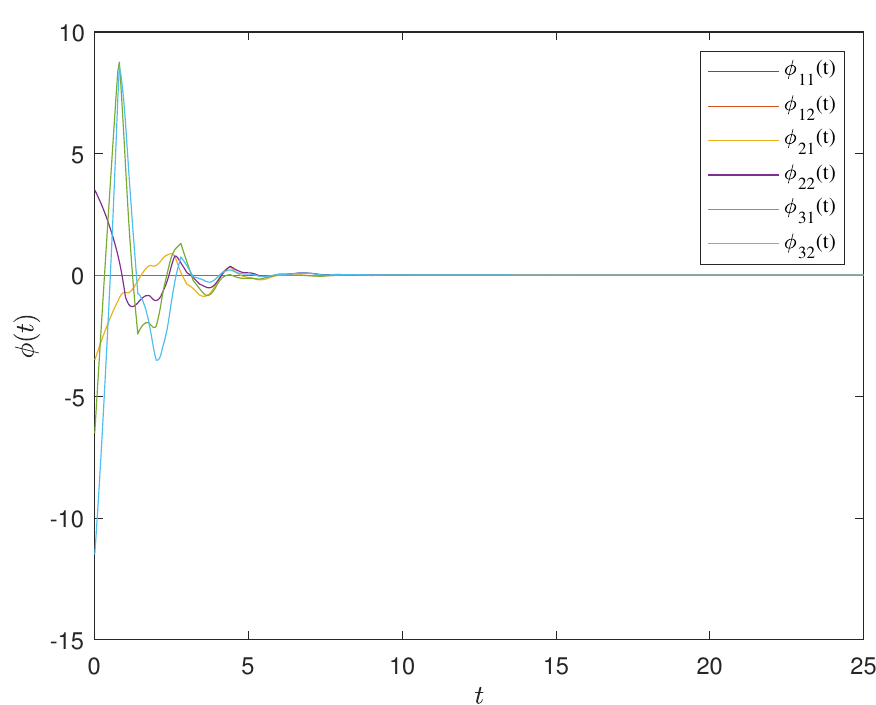
Figure 16. The state trajectory of the error system under the improved event-triggering control input in Example 2. Under the designed improved event-triggered controller, the system achieved synchronization performance.